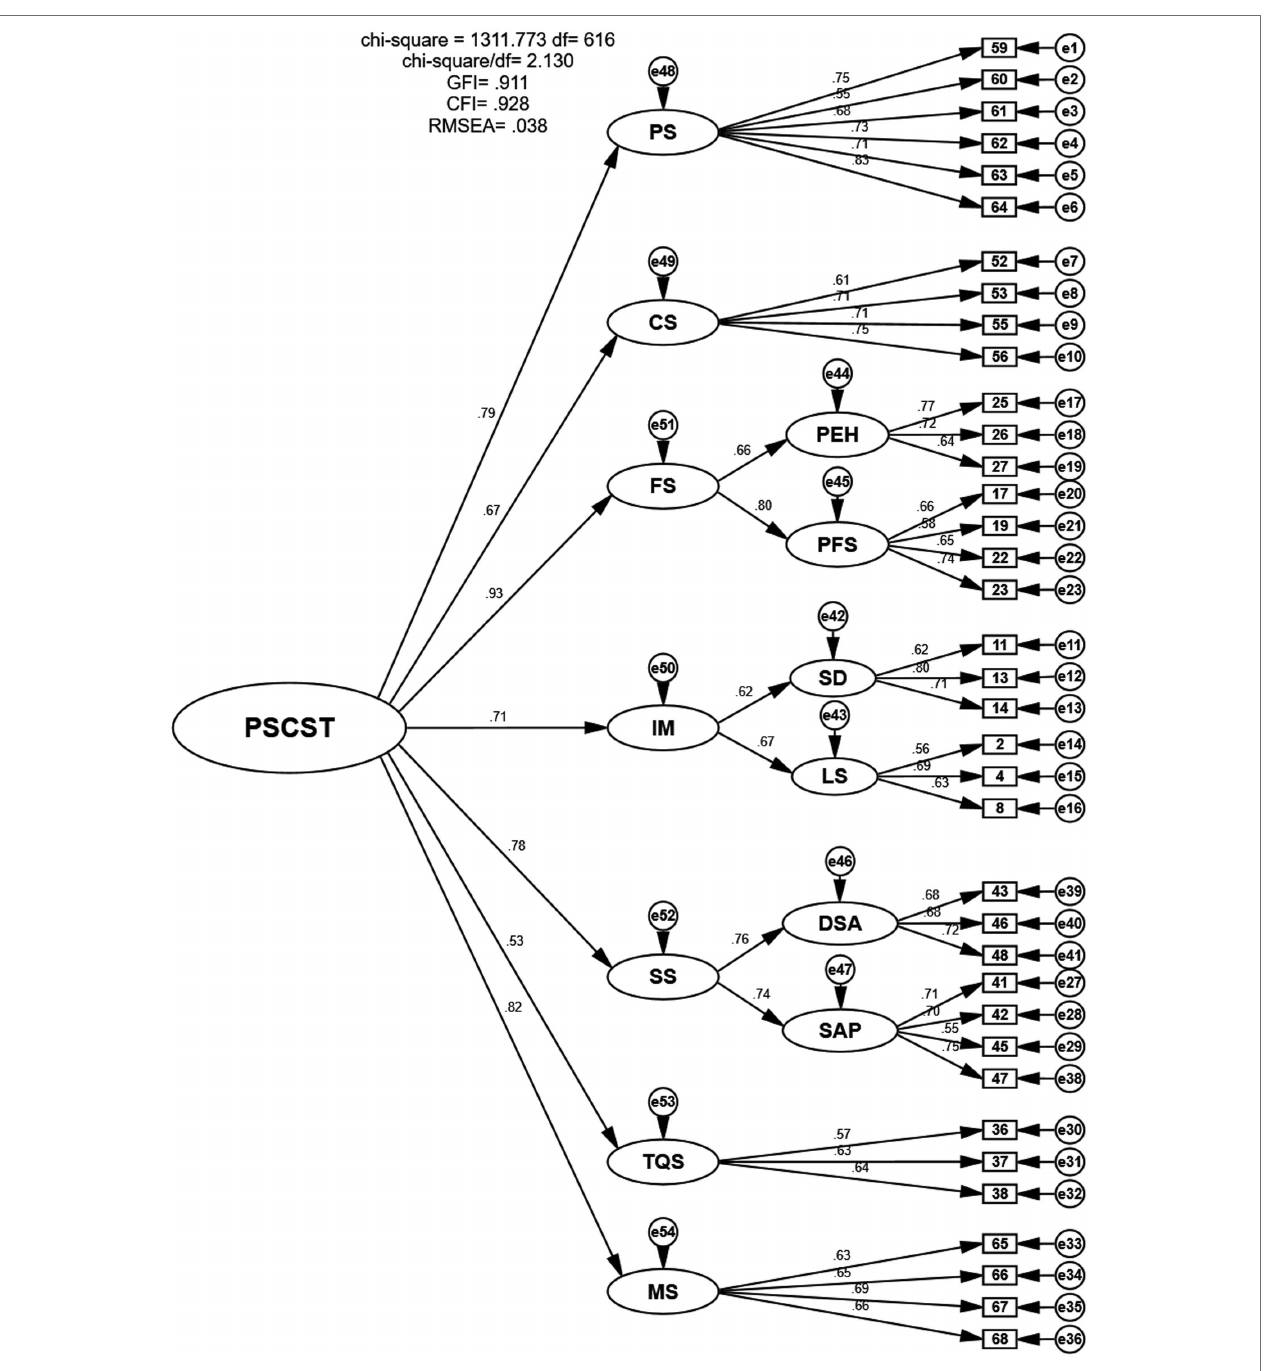
FIGURE 1 | Third-order factor model of parental support for children’s sports training